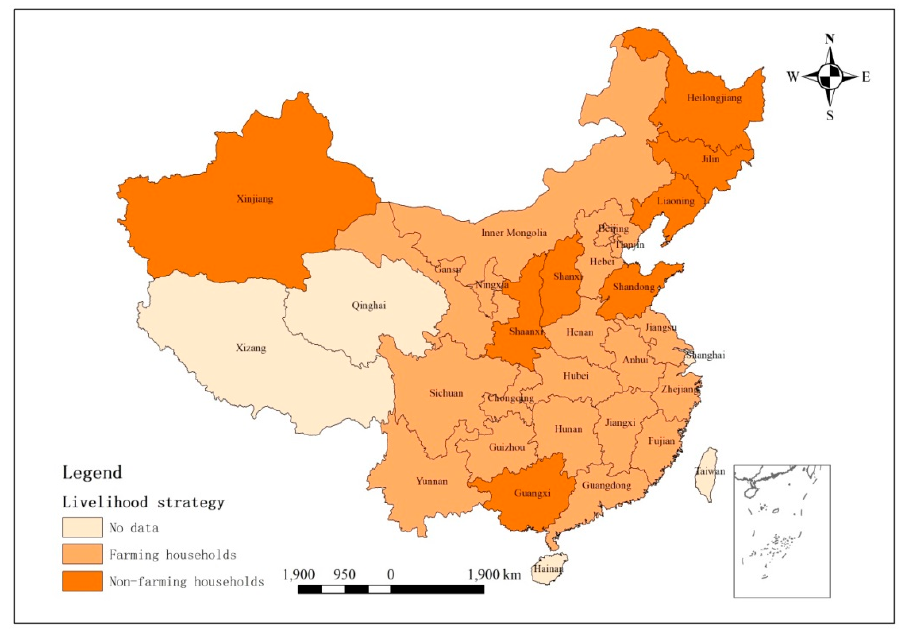
Figure 1. Spatial distribution of the livelihood strategy selection of rural households.